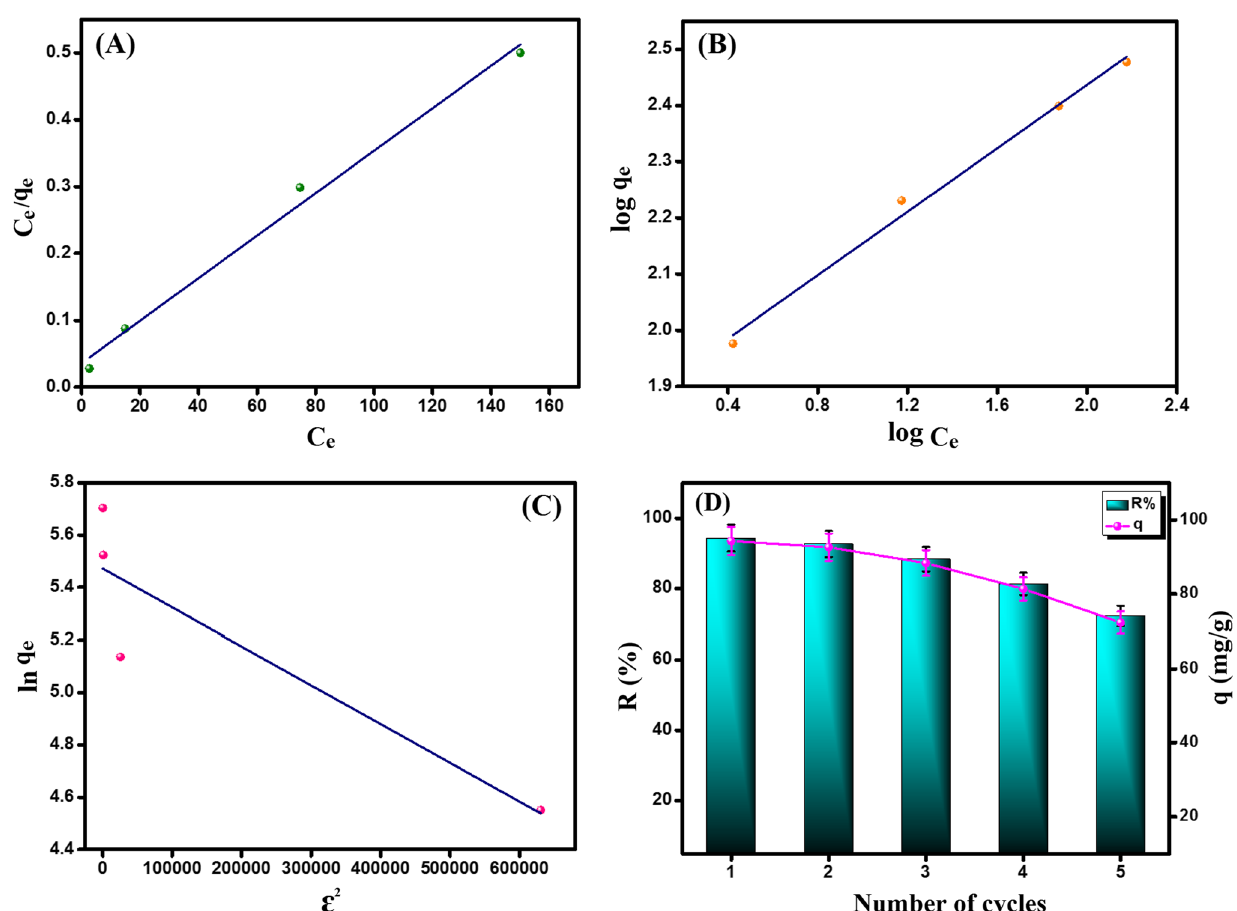
Fig. 6 Isotherm study; A Langmuir, B Freundlich, C D-R, and D Reusability study